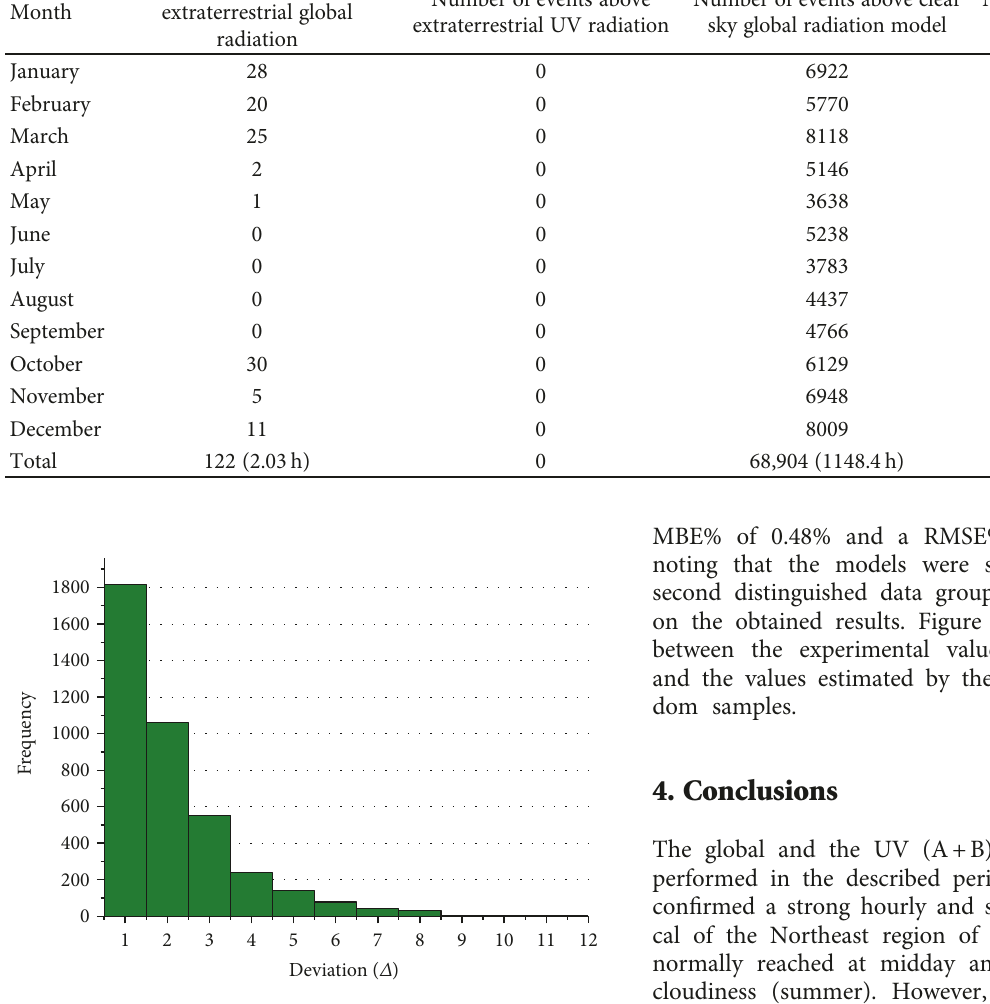
Figure 5: Occurrence probability of the event for the di ff erences between measured and modeled UV solar radiation (clear sky).